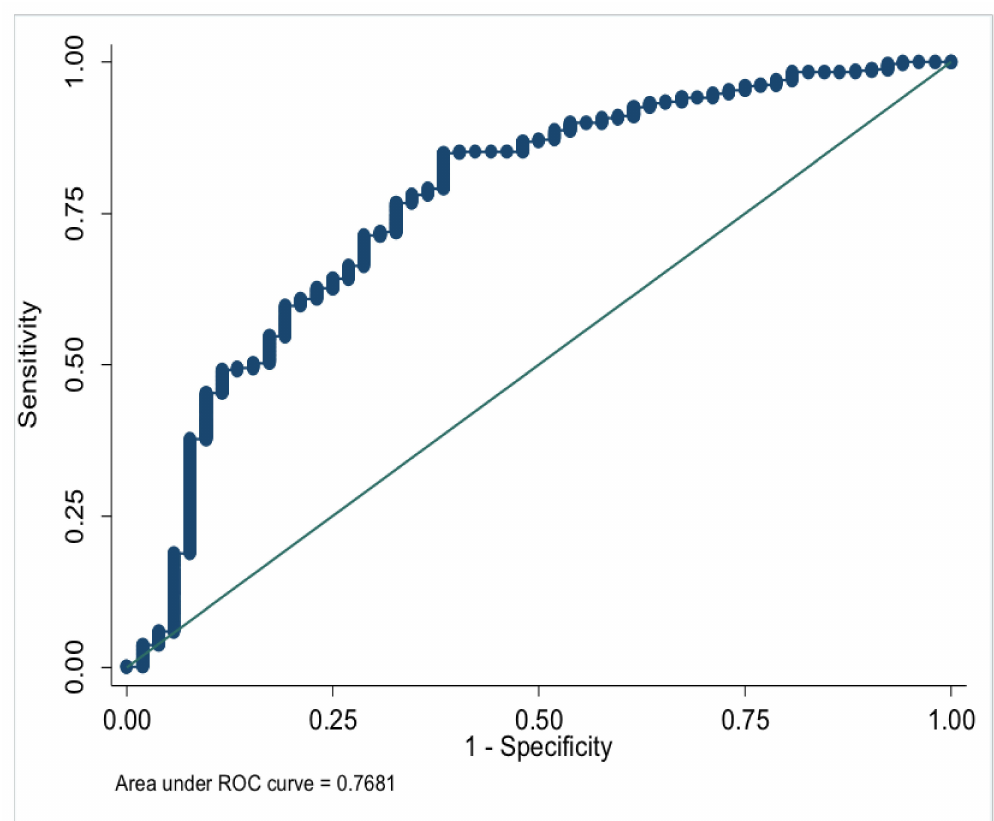
Figure 1. ROC of model parameters to distinguish NPM and benign breast mass.